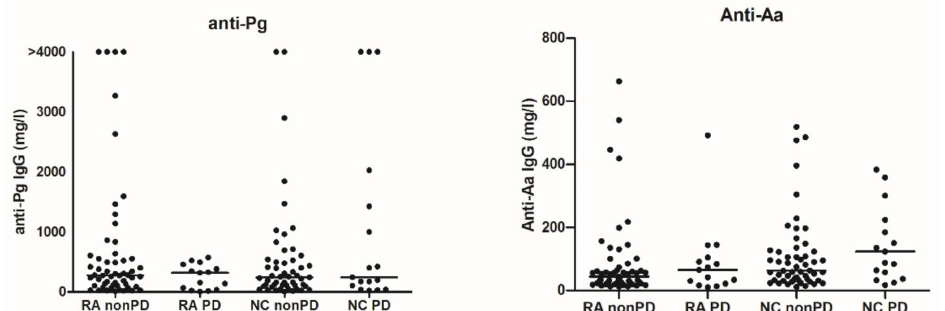
Figure 2. Levels of anti- P. gingivalis (Pg) and anti- A. actinomycetemcomitans (Aa) antibodies in relation to the presence or absence of periodontitis (PD) in RA patients and non-RA controls (NC). Lines represent the median.